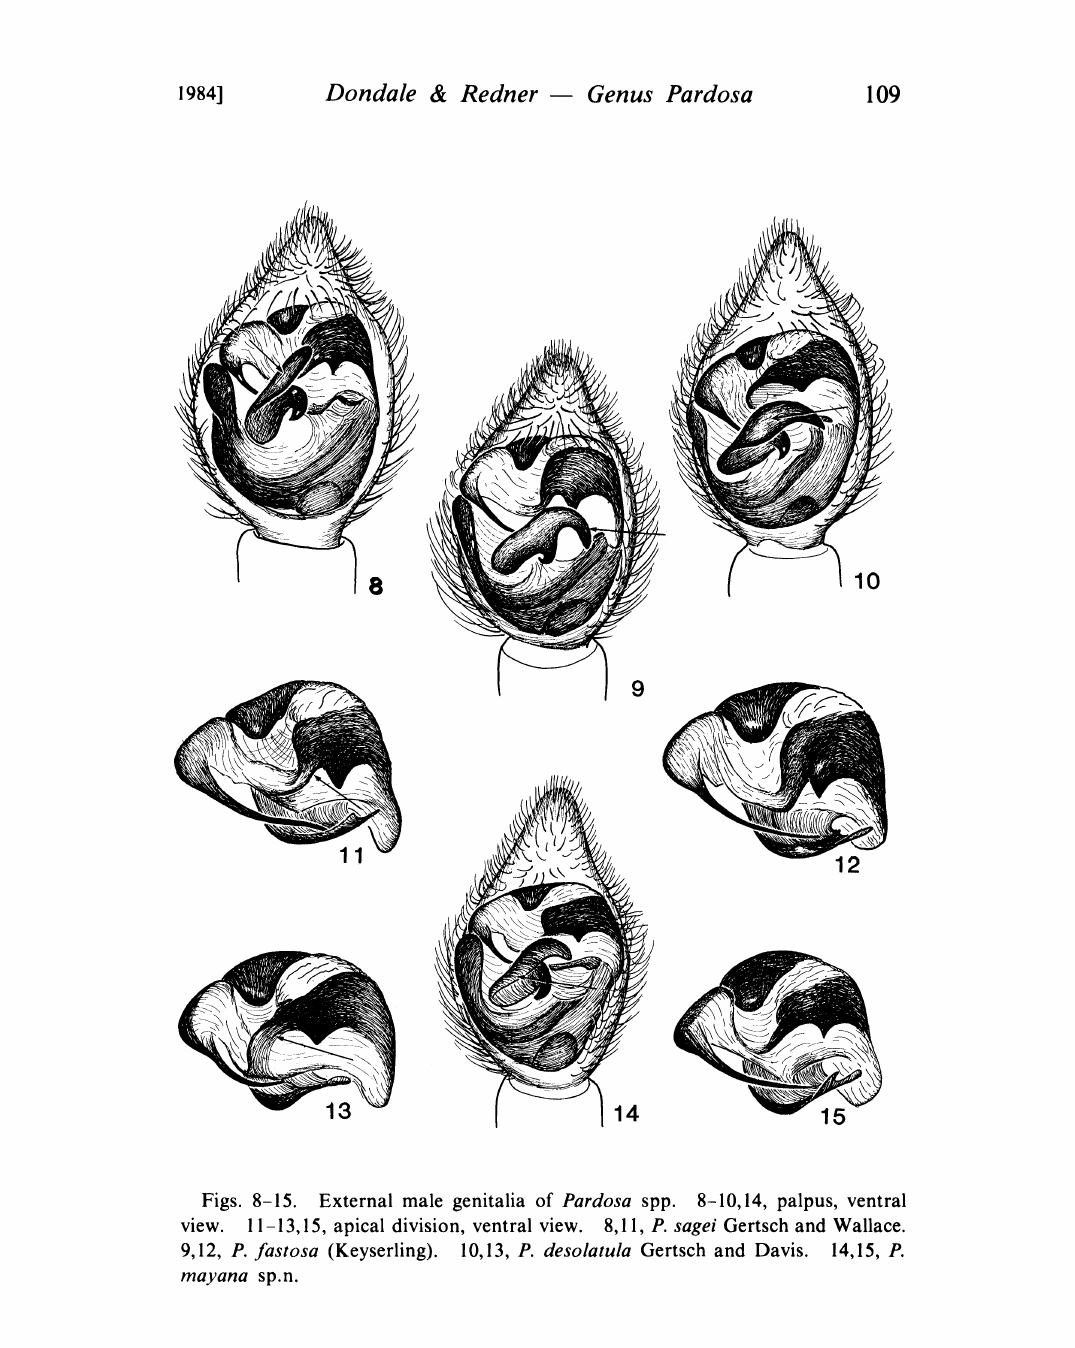
Figs. 8-15. External male genitalia of Pardosa spp. 8-10,14, palpus, ventral view. 11-13,15, apical division, ventral view. 8,1 I, P. sagei Gertsch and Wallace. 9,12, P. fastosa (Keyserling). 10,13, P. desolatula Gertsch and Davis. 14,15, P. mayana